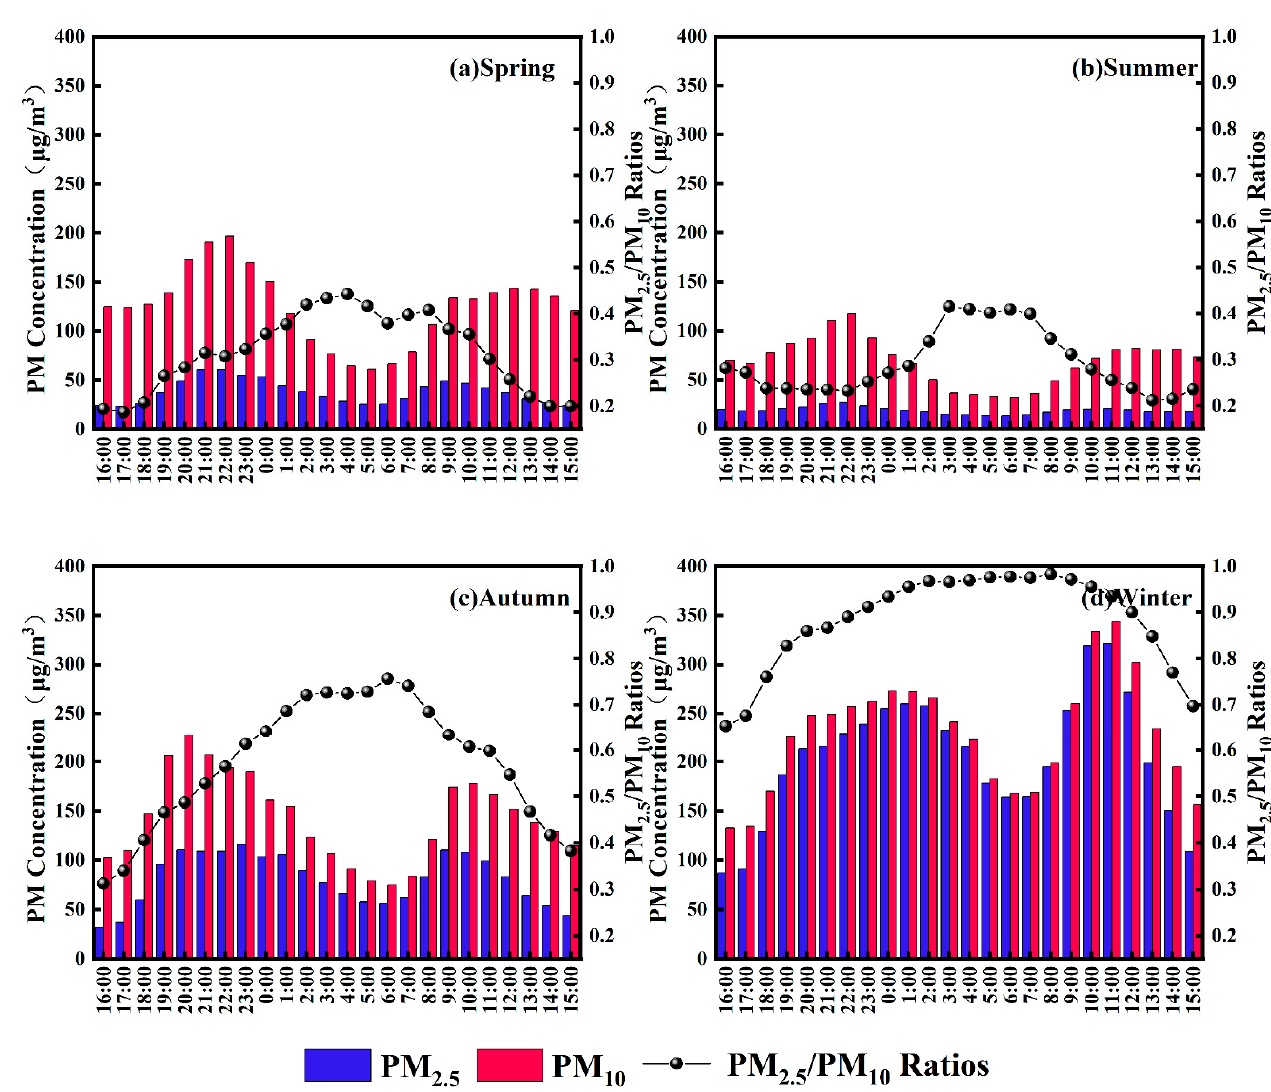
Figure 8. Hourly changes in the PM 2.5 /PM 10 ratio and PM concentration at urban sites in all four seasons from September 2017 to February 2019 ( a – d ).